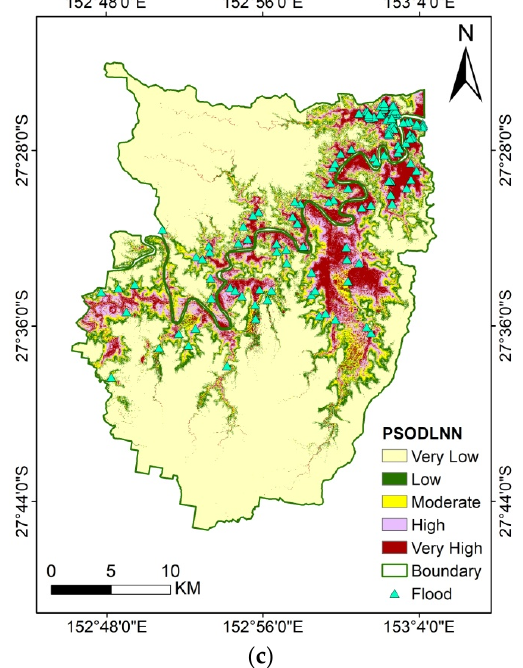
Figure 6. Flood susceptibility maps simulated using different models: ( a ) ANN, ( b ) DLNN, and ( c ) PSO-DLNN. The percentages of flood inventory samples based on individual probability class are presented in the Figure 7. Predominantly, more than 80% of the samples were classified as “very high” probability by the three algorithms. A meaningful difference is seen in the “high” probability class by the PSO-DLNN algorithm, and almost 10% of the samples were categorized in that class. The proportions of other flood samples were minimal in other classes for every algorithm.